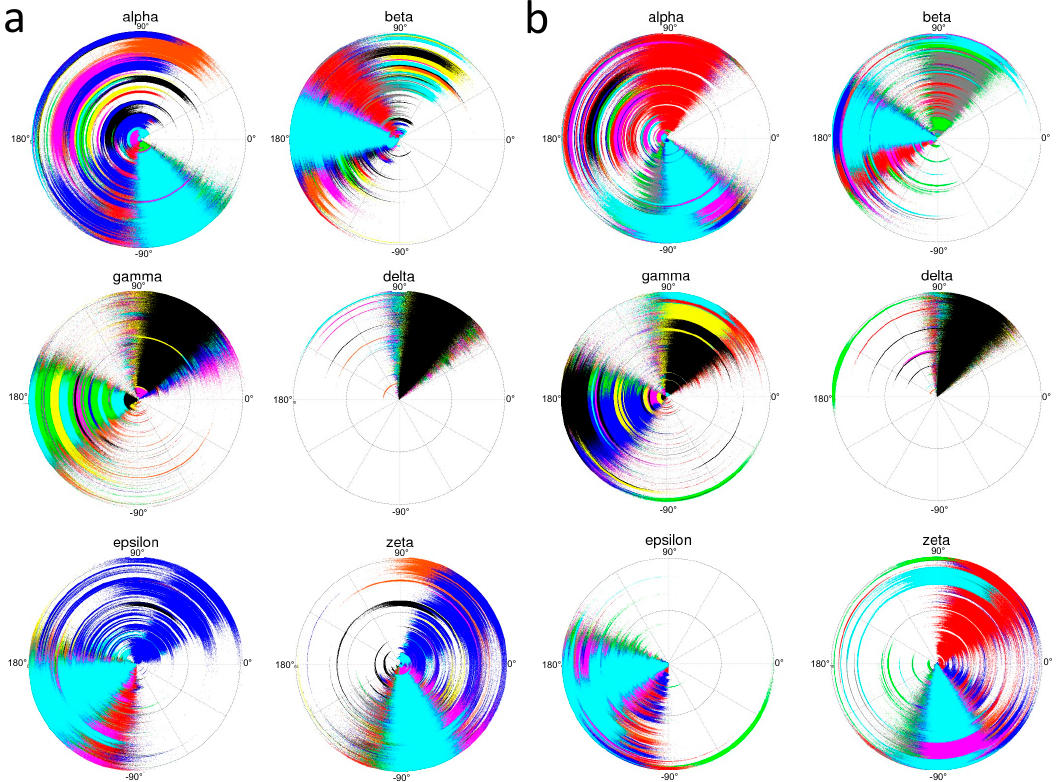
Figure 9. Radial plots representing a 100 ns time range of the MD trajectory (0 ns at center of circle) and illustrating for ( a ) the homo-DNA duplex in the dimer and ( b ) the isolated duplex, sampling of the α , β , γ , δ , ε, and ζ backbone torsion angles by nucleotides at each step of the octamer. Each nucleotide is depicted in a different color.